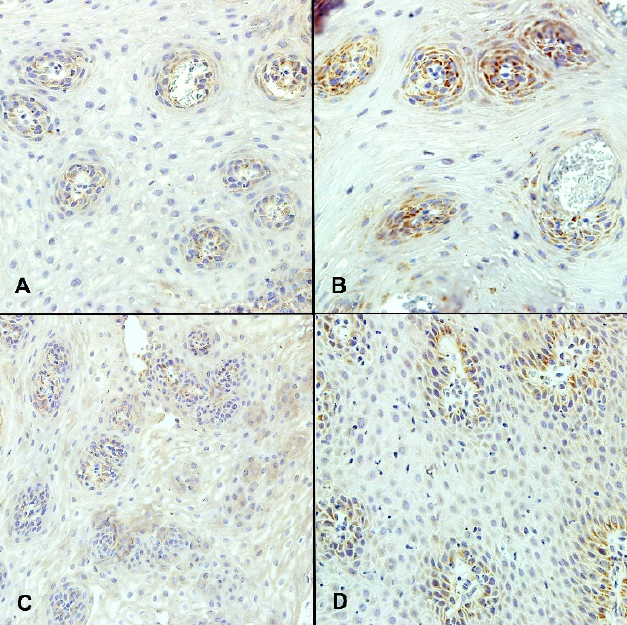
Figure 3. The expression of VEGF and VEGFR in esophageal squamous mucosa evaluated by immunohistochemistry. ( A )—low VEGF expression (positive in less than 33% of vessels) (magn. × 400); ( B )—high VEGF expression (positive in over 66% of vessels) (magn. × 400); ( C )—low VEGFR expression (positive in less than 33% of vessels) (magn. × 200); ( D )—high VEGFR expression (positive in over 66% of vessels) (magn. ×